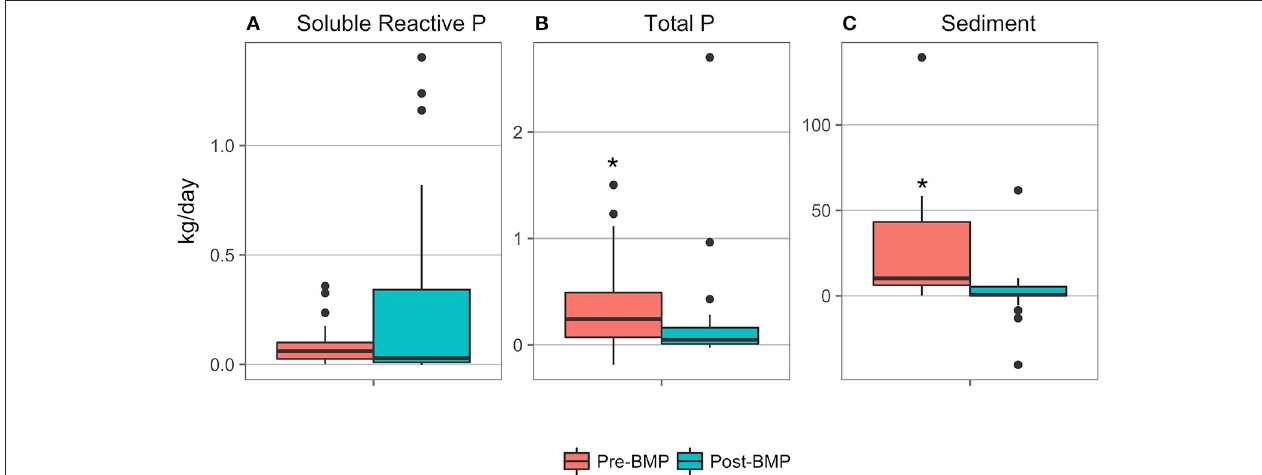
FIGURE 5 | Soluble reactive phosphorus (A) , total phosphorus (B) , and total suspended solids (C) loading accumulated across the site before and after the cattle excluded buffer was in place. TP and TSS accumulations are significantly different (as indicated by an asterisk, *), but SRP accumulation is unchanged. N = 25 for pre-BMP samples and n = 24 for post-BMP samples. A negative load accumulation indicates reduction of P or TSS load over the course of the